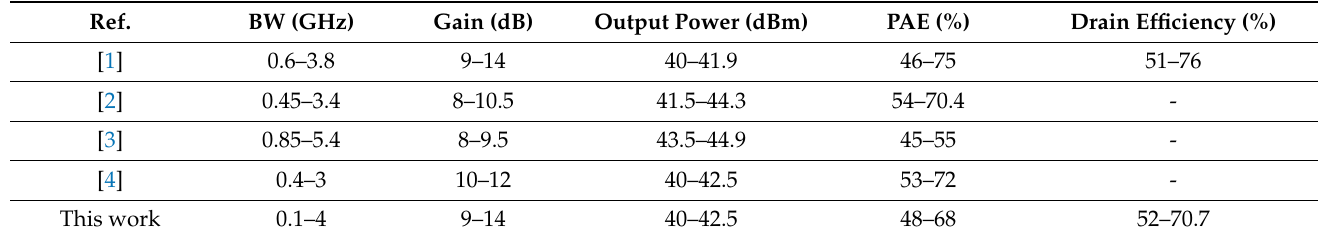
Table 1. Comparison of the designed and implemented PA with the state-of-the-art. Ref.